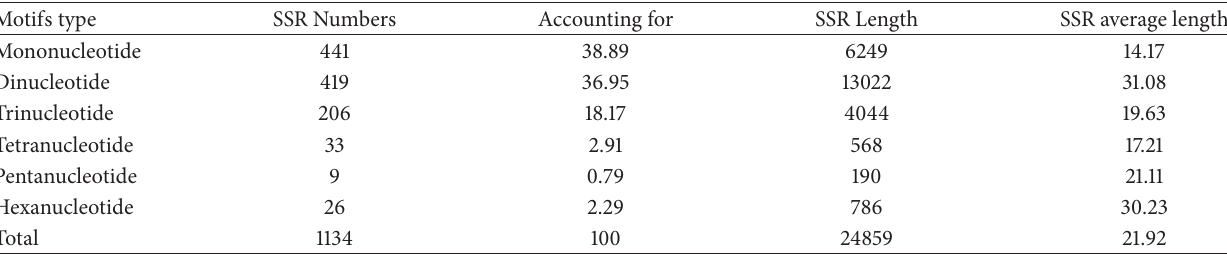
Table 2: Distribution to different repeat type